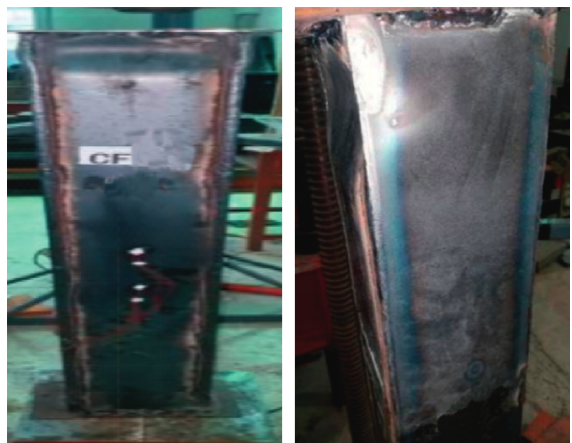
Figure 22: CF-3 failure mode.